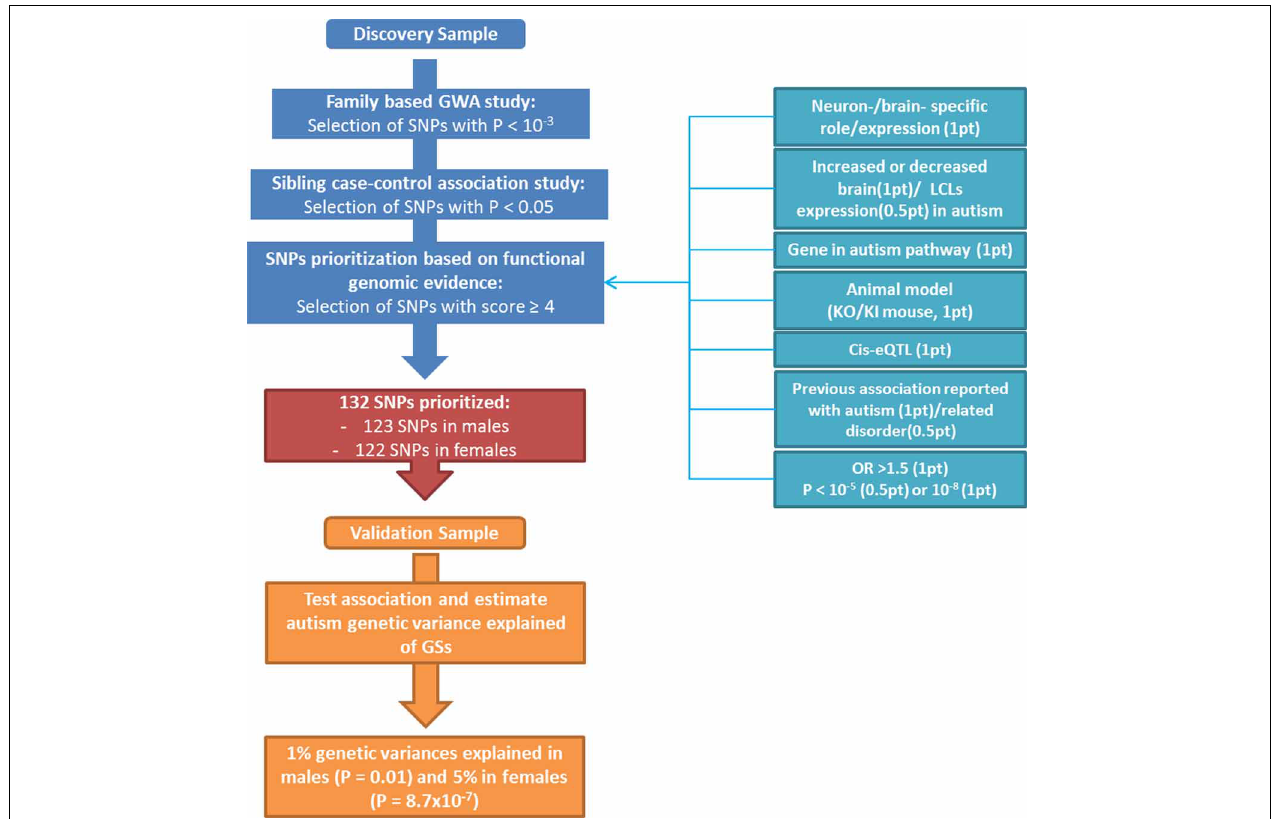
FIGURE 1 | Flow chart displaying the different steps for SNPs prioritization with details of the scoring